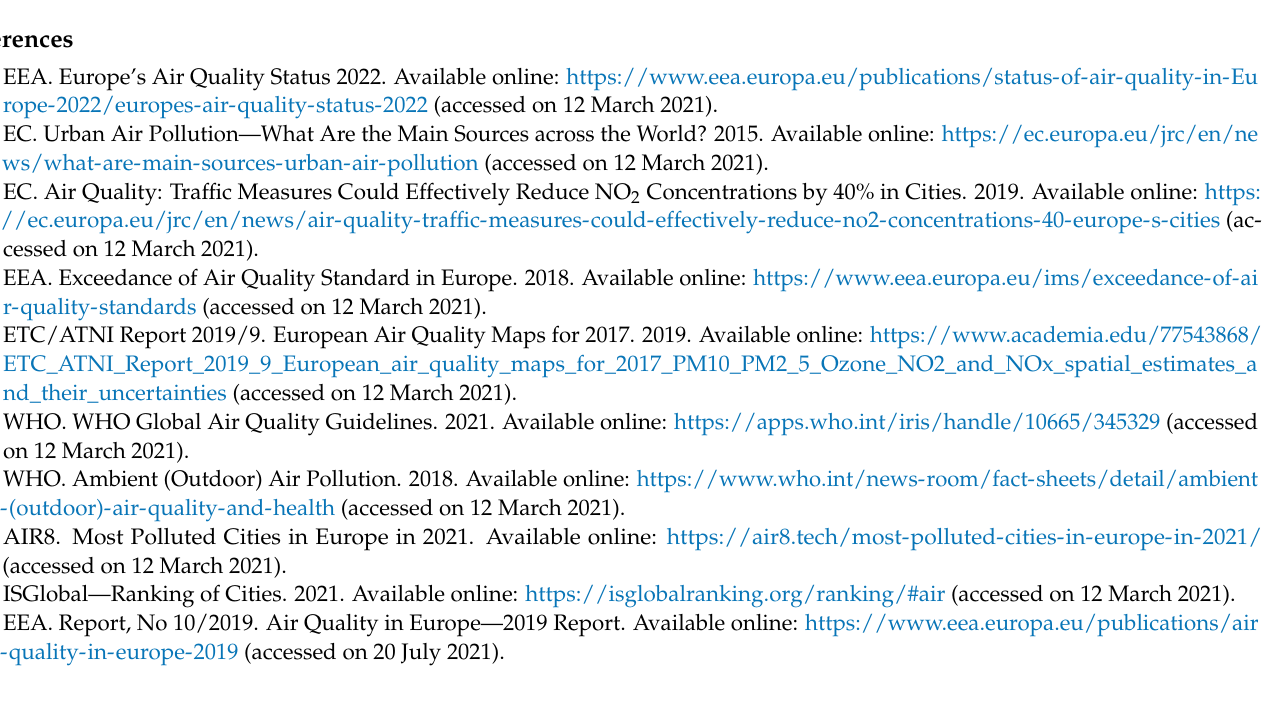
Table S2. Euro Norms for the diesel cars; Table S3. Euro Norms for HDV diesel cars; Table S4.